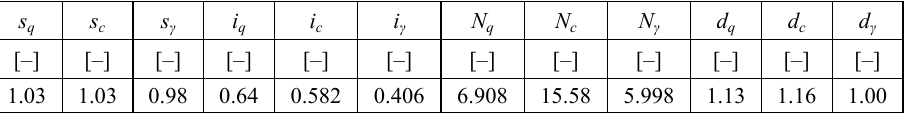
Table 4. Values of coefficients in equation (12) calculated at the design